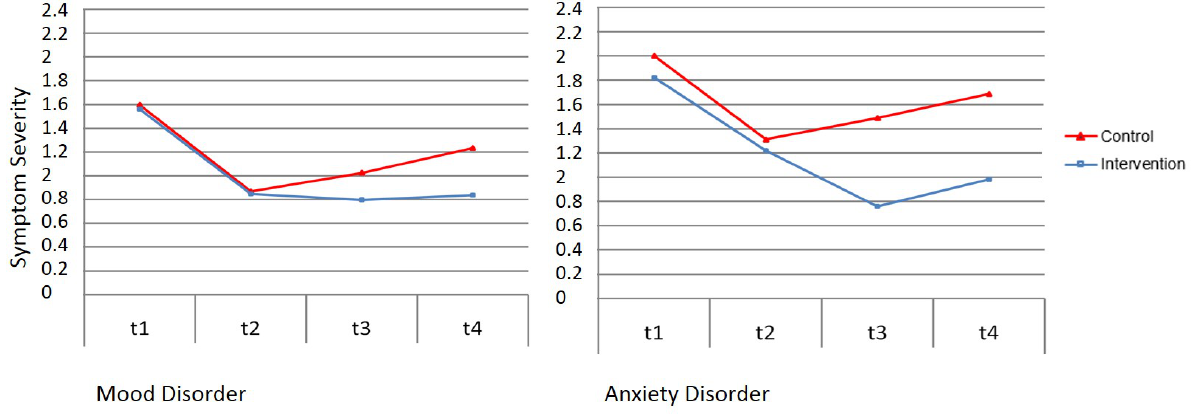
Figure 3. Estimated course of symptoms based on simple slope mixed-effect model analyses for significant moderator effect of diagnoses (0=mood disorder, n=221; 1=anxiety disorder, n=37) at inpatient admission (T1), inpatient discharge/begin transdiagnostic Internet-based maintenance treatment (T2), 3-month follow-up/end transdiagnostic Internet-based maintenance treatment (T3), and 12-month follow-up